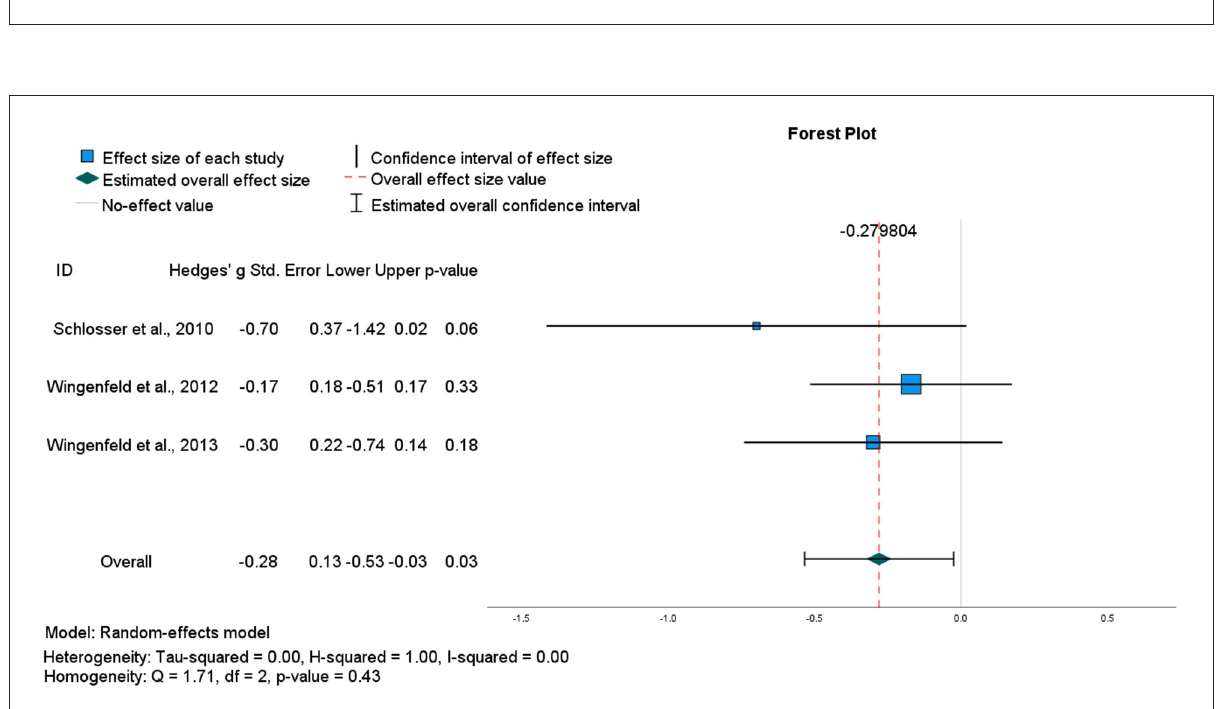
FIGURE2 Forest plot for pooled studies of the (acute) effect of oral hydrocortisone (10mg) administration in healthy participants on the number of specific AMs recalled.